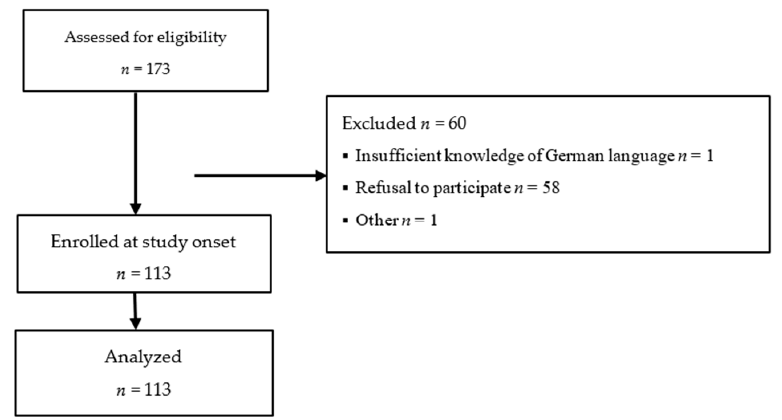
Figure 1. Patient enrolment and attrition. Table 1. Characteristics of the study sample.